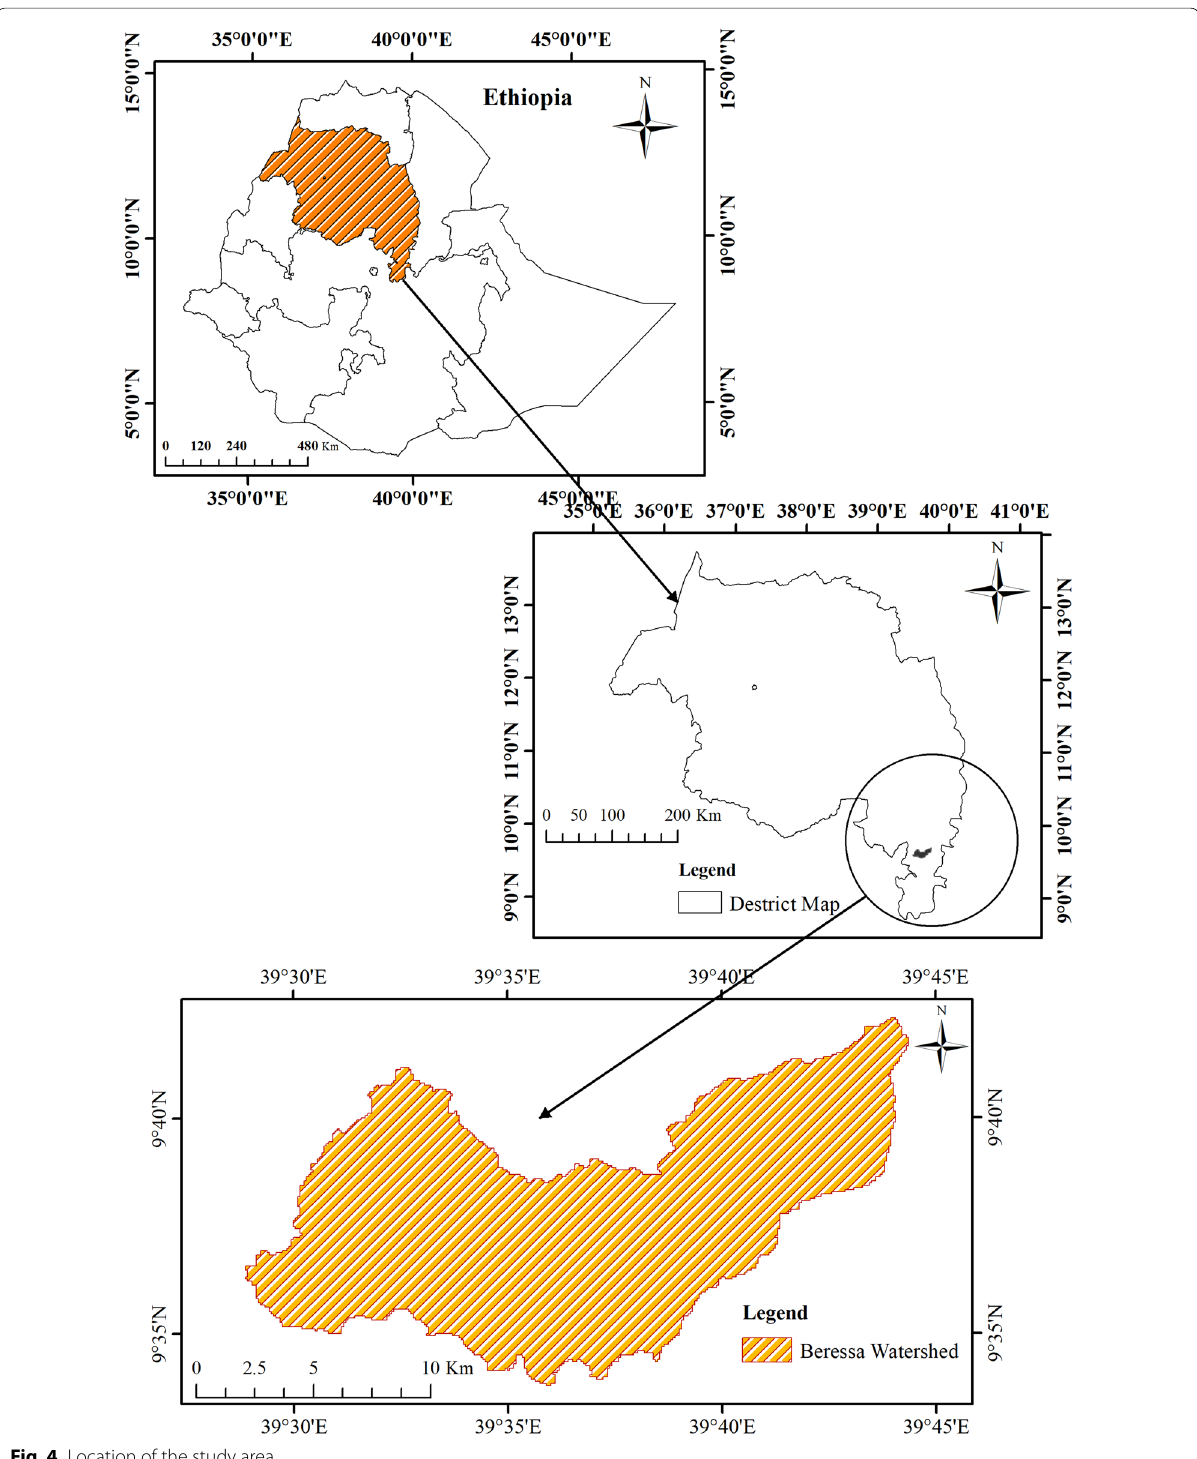
Fig. 4 Location of the study